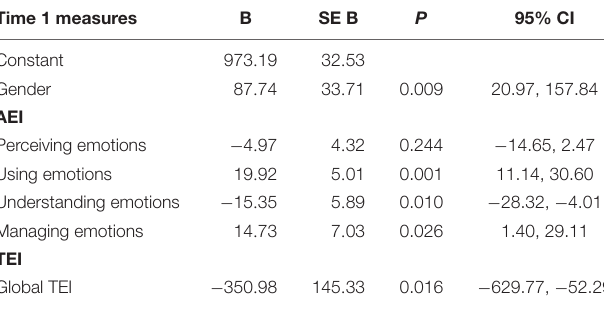
TABLE 3 | Bootstrapped regression analysis with AEI and TEI as predictors of prolonged